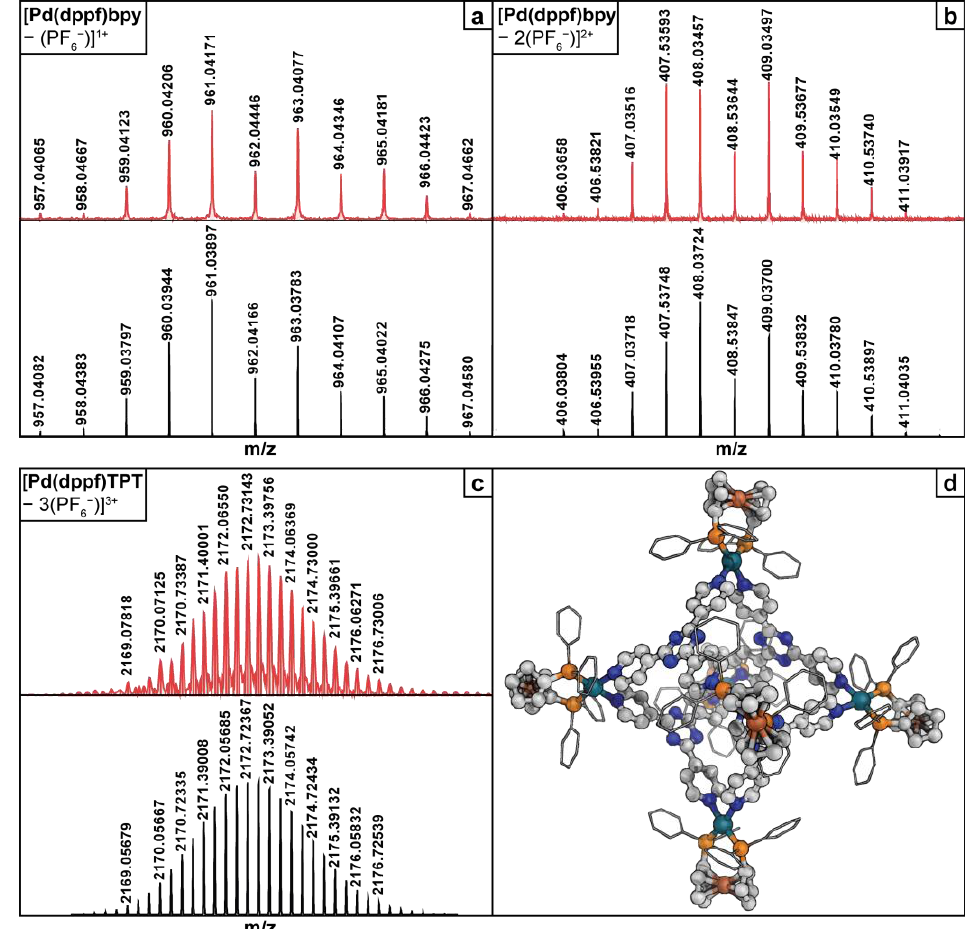
Figure 2. ( a – c ): Experimental (top, red) FT-ICR and simulated (bottom, black) mass spectra of: ( a ). [Pd(dppf)bpy − (PF 6 − )] 1+ , ( b ). [Pd(dppf)bpy − 2(PF 6 − )] 2+ , ( c ). [Pd(dppf)TPT − 3(PF 6 − )] 3+ . ( d ). Single crystal structure of Pd(dppf)TPT. Hydrogen atoms are omitted for clarity.